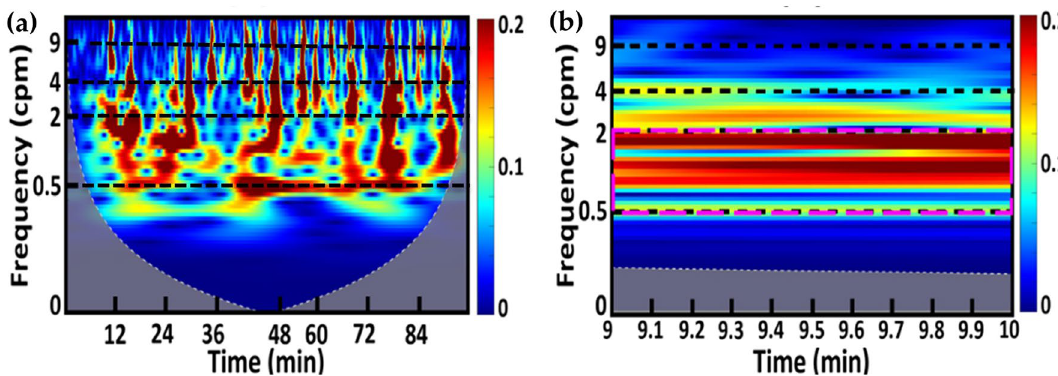
Figure 7. Continuous wavelet transform. ( a ) A CWT-derived spectrogram from a neonate during Feeding 1, including 30-min pre-feed, 30-min during feed, and 36-min post-feed. (Note that this 36-min Post-feed was used only for plot purpose. Only the 30-min Post-feed time was considered for both PSD and % time calculations). The horizontal x-axis represents time in min; the vertical y-axis denotes the frequency in cpm between 0 and 10 cpm plotted in log scale; the color bar represents wavelet transform power of an EGG time series. Several horizontal dashed lines mark the three GR bands of interest (bradygastria: 0.5 ≤ GR < 2 cpm;